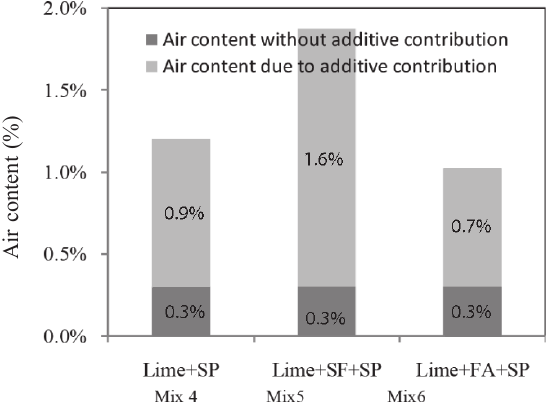
Fig. 6. SEM image of 7-days hardened grout with SF (mix 2) at 3000x